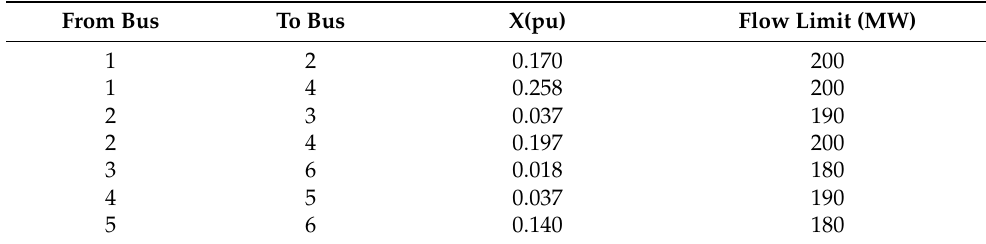
Table A9. Network